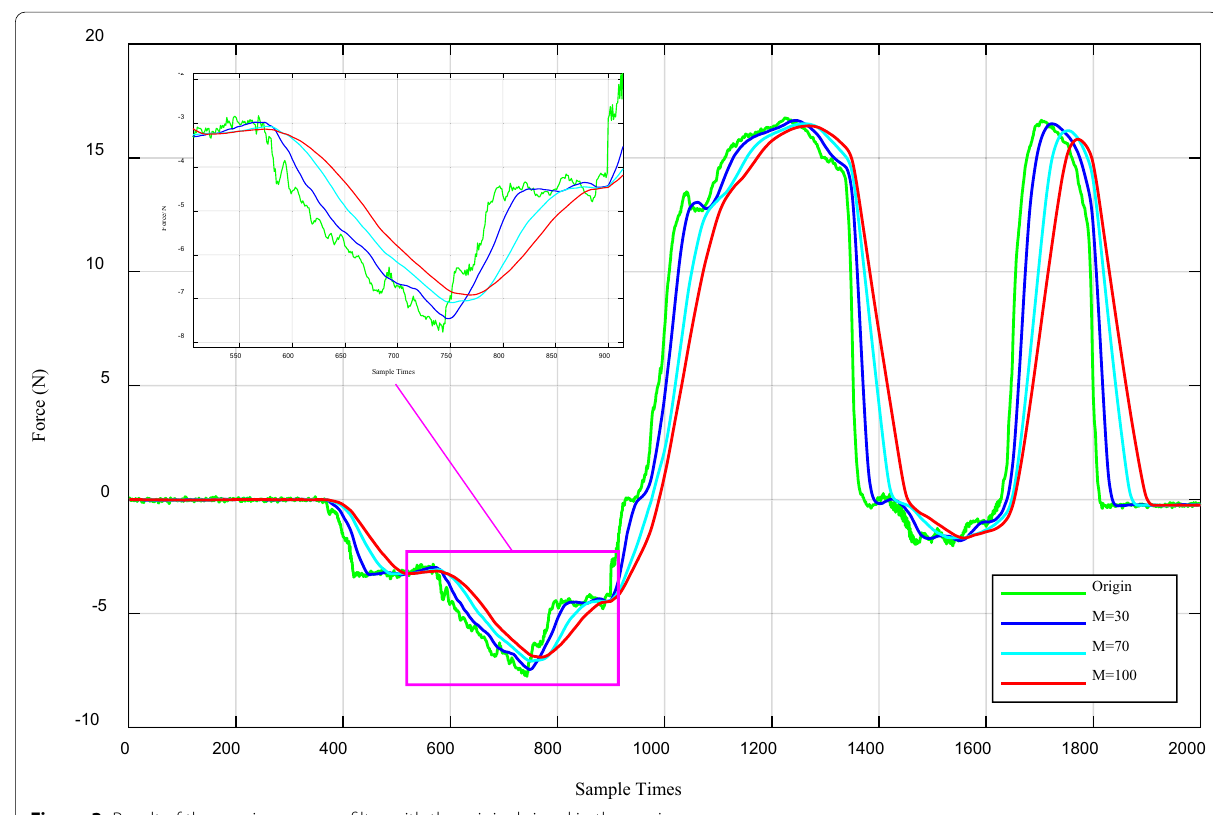
Figure 3 Result of the moving average filter with the original signal in the x